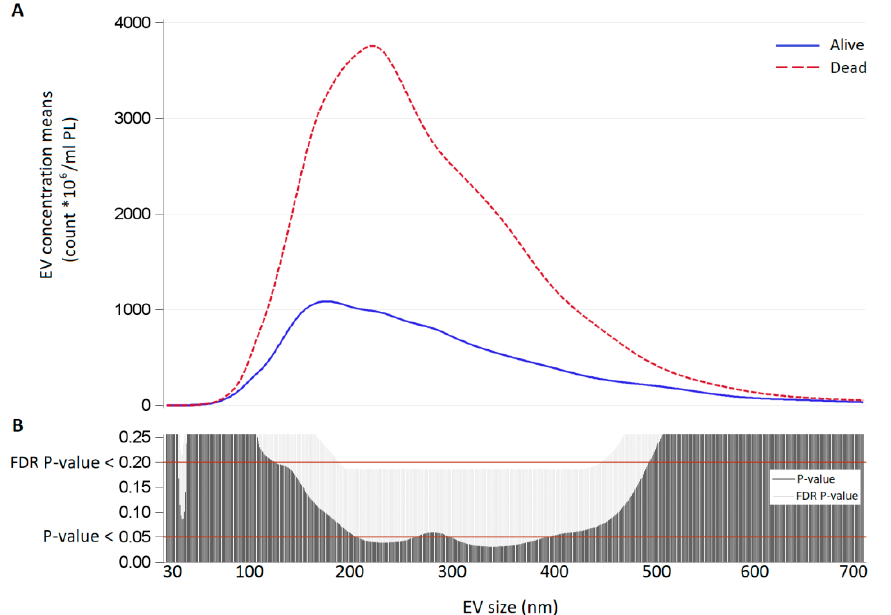
Figure 3. ( A ) EV concentration means (count × 10 6 /mL) for each size (30–700 nm) in tracheal fluid samples of survivors (continuous blue line) and non-survivors (dashed red line). ( B ) Significance of the difference between survivors and non-survivors for each EV size expressed as p -value and False Discovery Rate p -value from Poisson regression models allowing for over-dispersion.